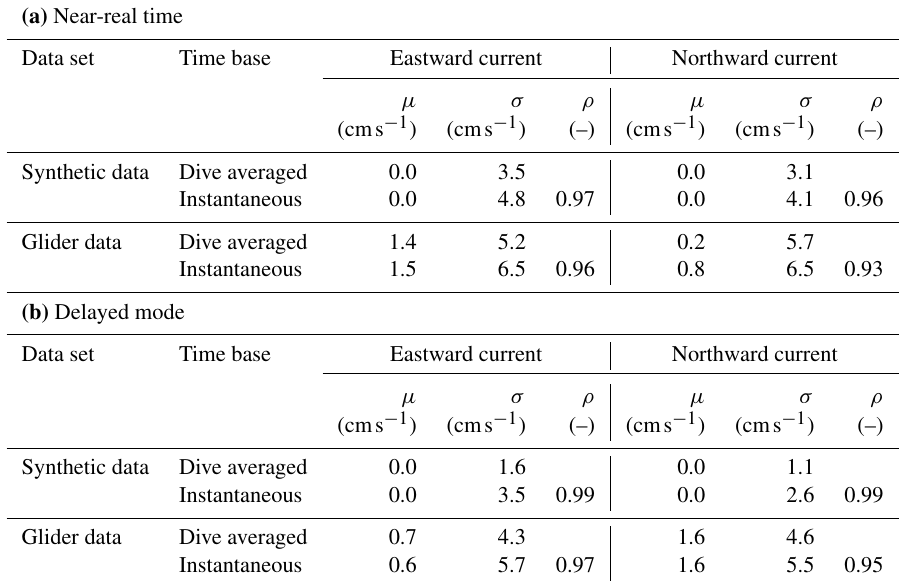
Table 1. Mean ( µ ) and standard deviation ( σ ) of the difference between ADCP observations and (a) near-real-time current estimates and (b) delayed mode current estimates. The correlation coefficient ( ρ ) is calculated from the instantaneous estimated values and observations, for both the near-real-time and delayed mode data. The synthetic data set is derived from ADCP measurements, with added noise (see text). Dive-averaged current estimates assume 3h dives.